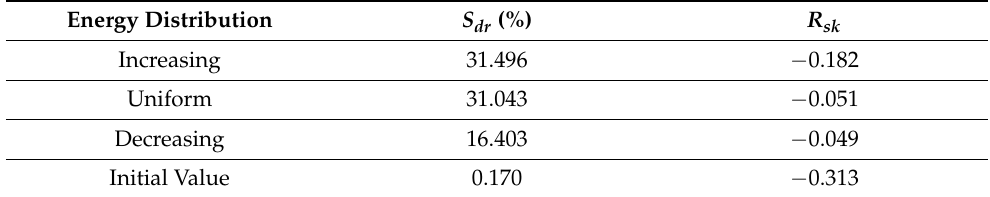
Table A10. S dr and R sk of titanium.